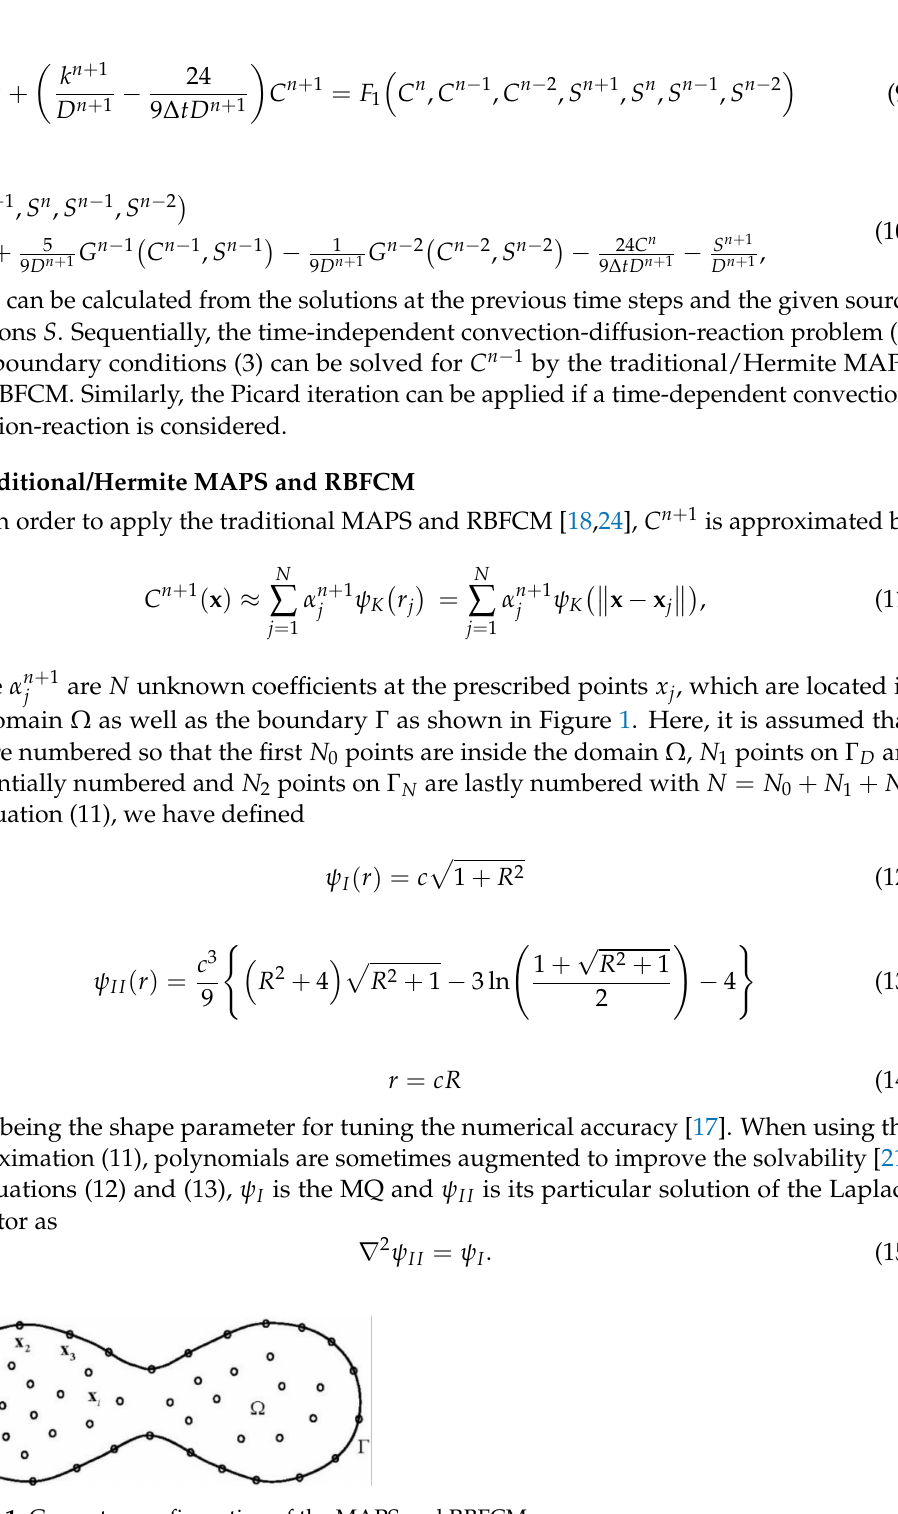
Figure 1. Geometry configuration of the MAPS and